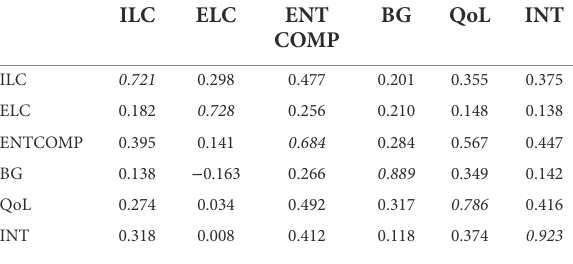
TABLE 3 Discriminant